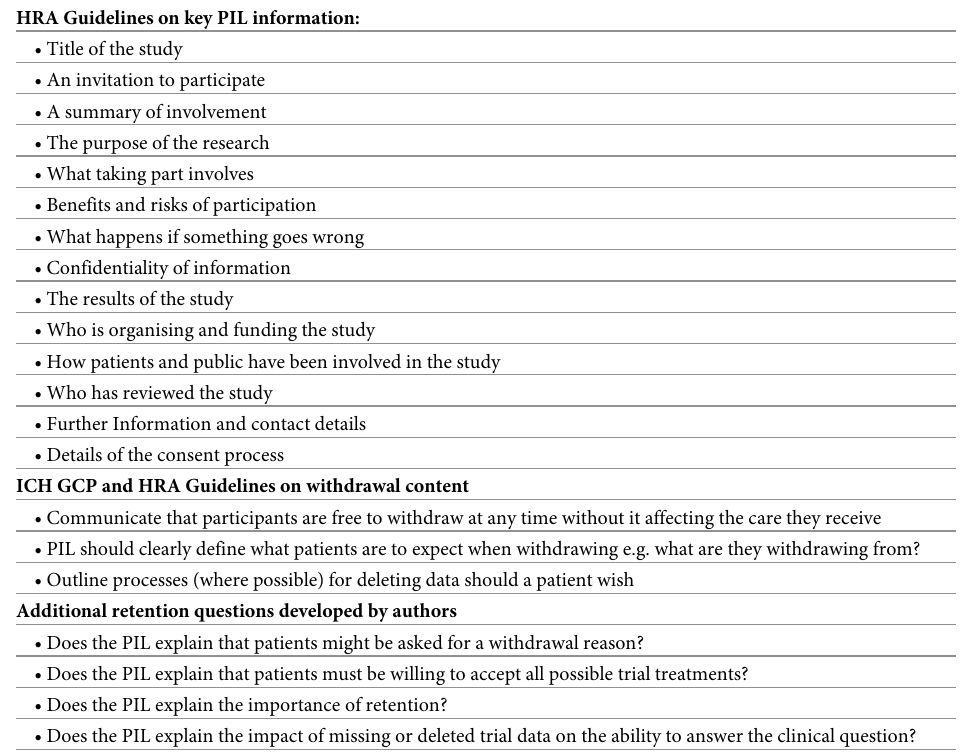
Table 1. Checklist of retention content for